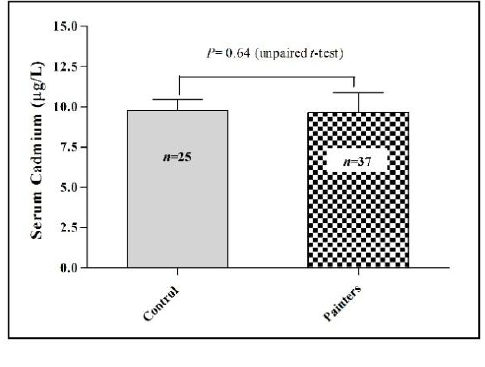
Figure (2): Changes in serum urea levels of painting workers in Sulaimani city. n : number of subjects; P <0.05: significant difference compared with control group.